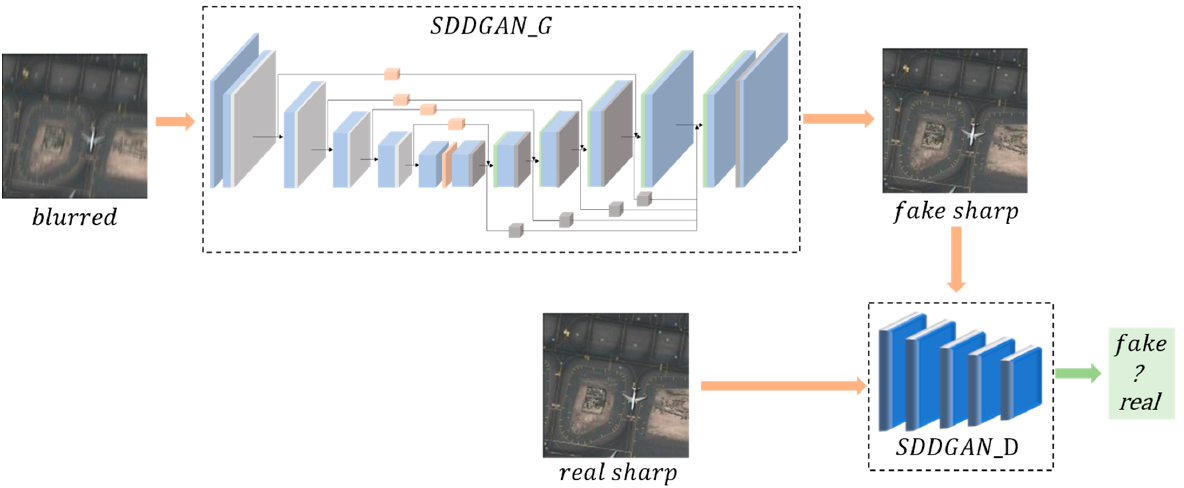
Figure 1. The SDD-GAN framework.